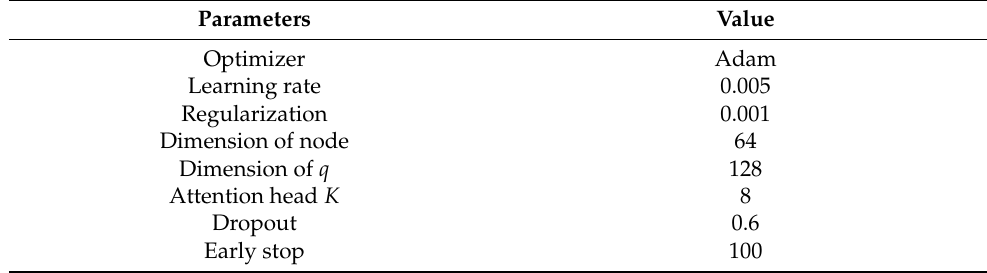
Table 2. Experiment parameter setting.